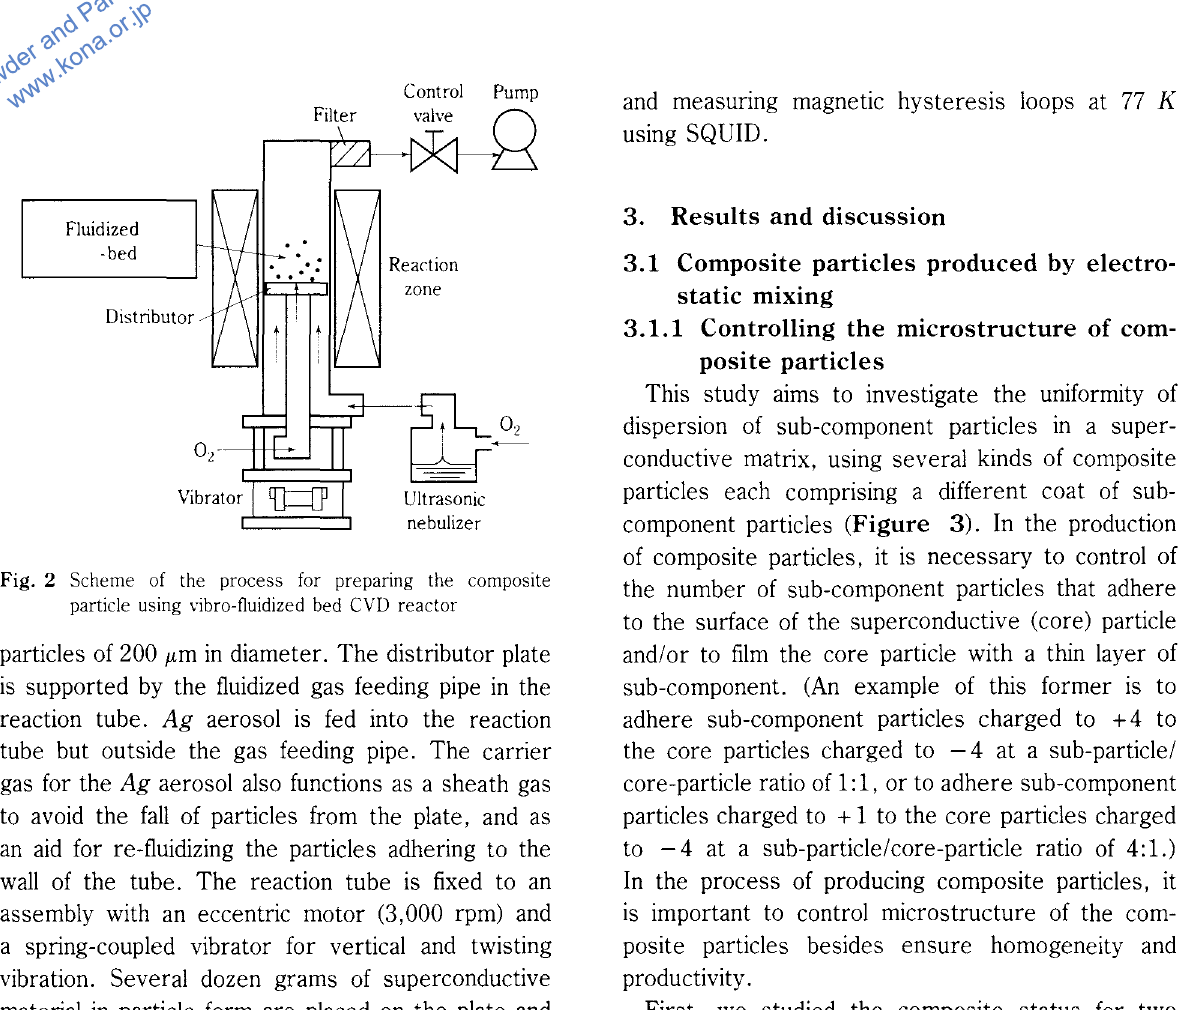
Fig. 2 Scheme of the process for preparing the composite particle using vibro-fluidized bed CVD